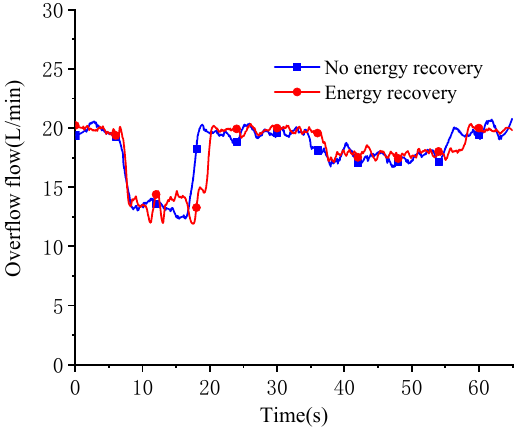
Figure 33. Overflow oil.